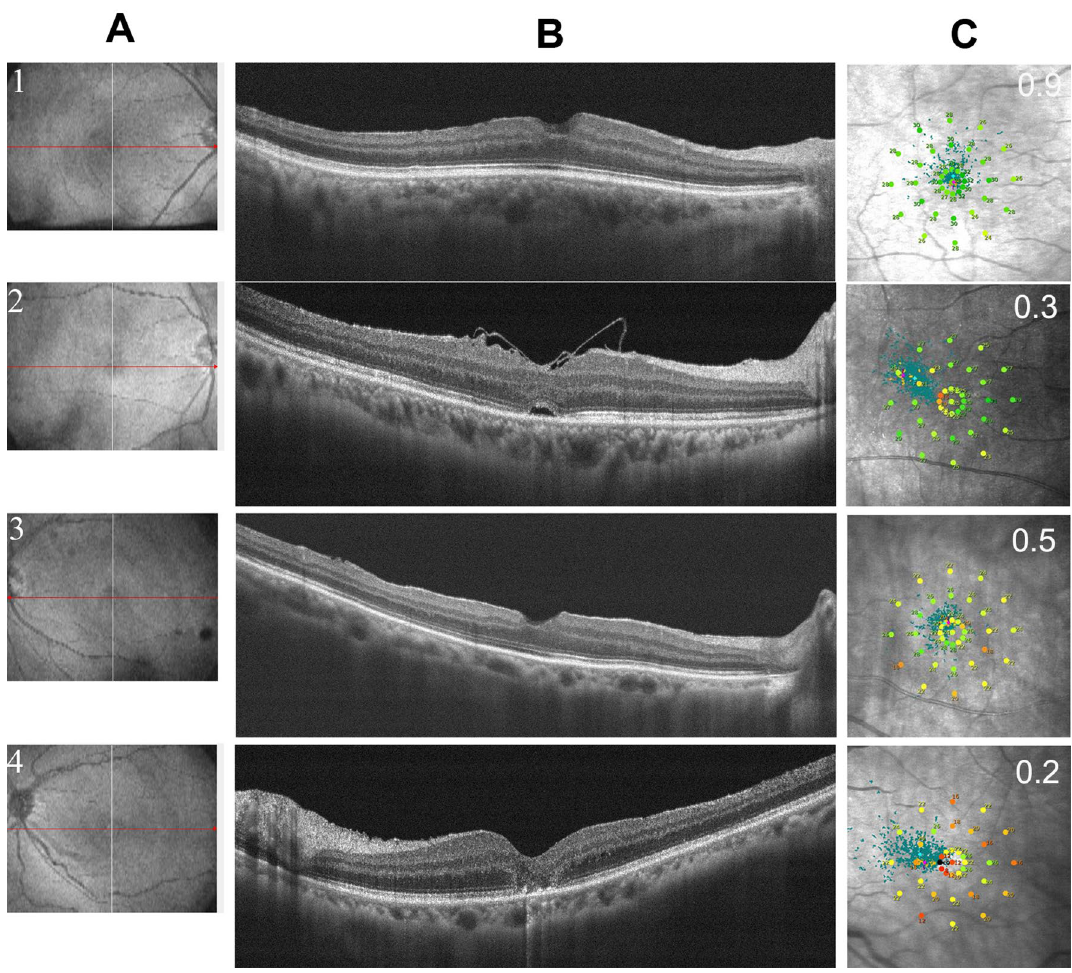
Figure 2. Results of OCT and MAIA examinations in patients with different fixation locations 3 months after surgery. Columns ( A ) and ( B ) show the location of the OCT scan and the horizontal B scan, and column ( C ) shows the MAIA results of the corresponding patients. The first row shows the OCT and MAIA results of patients with foveolar fixation locations, and rows 2, 3 and 4 show the results of patients with temporal, superior, and nasal fixation locations,